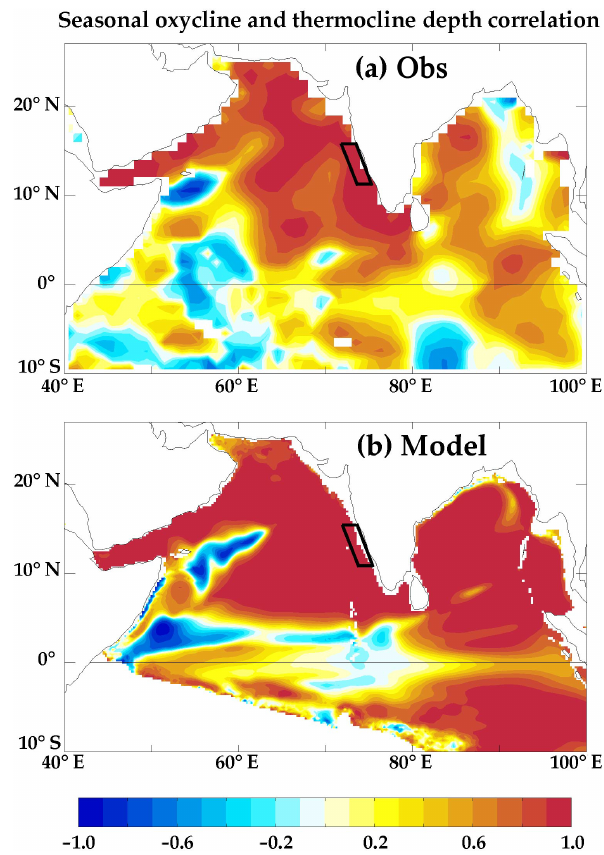
Figure 5. Maps of correlation between the mean seasonal cycle of oxycline and thermocline depths over the northern Indian Ocean from (a) WOA13 and (b) model. Values are masked when the oxy- cline could not be defined, i.e., when the oxygen concentration is above 100µmolL − 1 in the entire water column. The WCI box is marked as a black frame on each